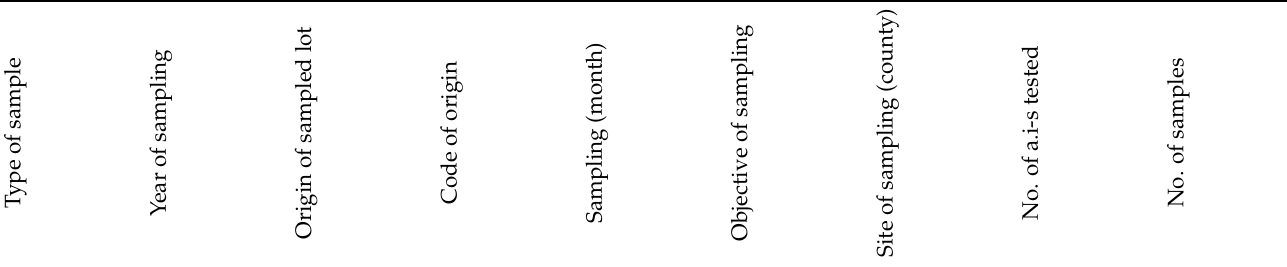
Table A5. Summary of results according to type and origin of sampled lots.